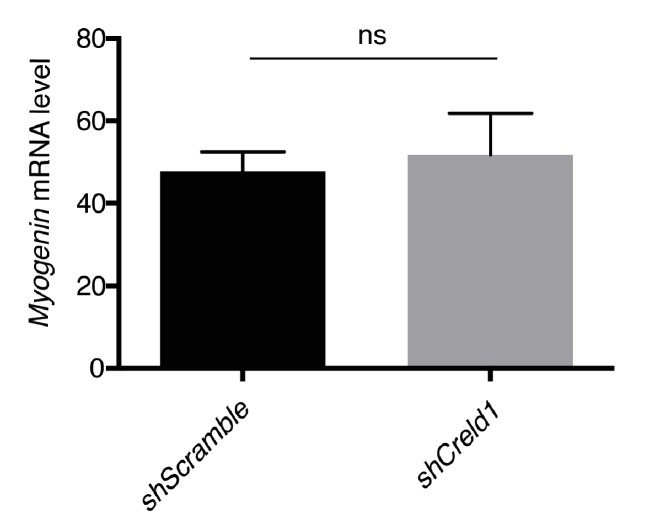
Knocking down Creld1 does not impact Myogenin transcriptional levels.C2C12 cells expressing Scramble or Creld1 shRNA were differentiated for 5 days, and then subjected to RNA extraction. Quantitative real-time PCR measurements of mRNA levels shows that Myogenin is not significantly decreased in shCreld-1 cells. Fold-change, mean ± SEM in shCreld-1 relative to shScramble (100%) is shown in four independent experiments. p>0,9999, ns (not significant), Mann–Whitney test.